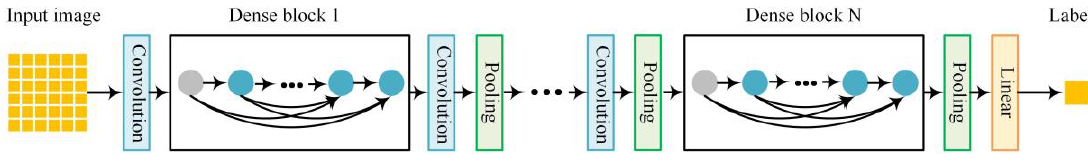
Figure 1. DenseNet architecture with dense blocks and transition layers.